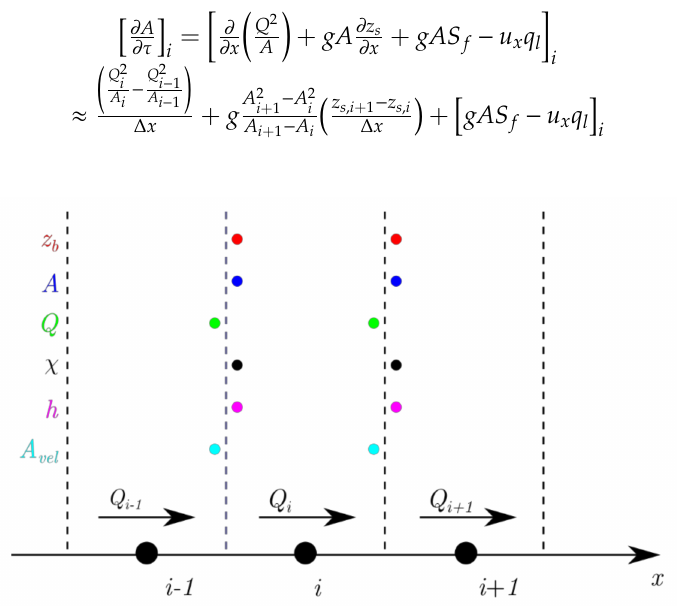
Figure 2. Upwinding directions of the unknown and flow properties in the computation